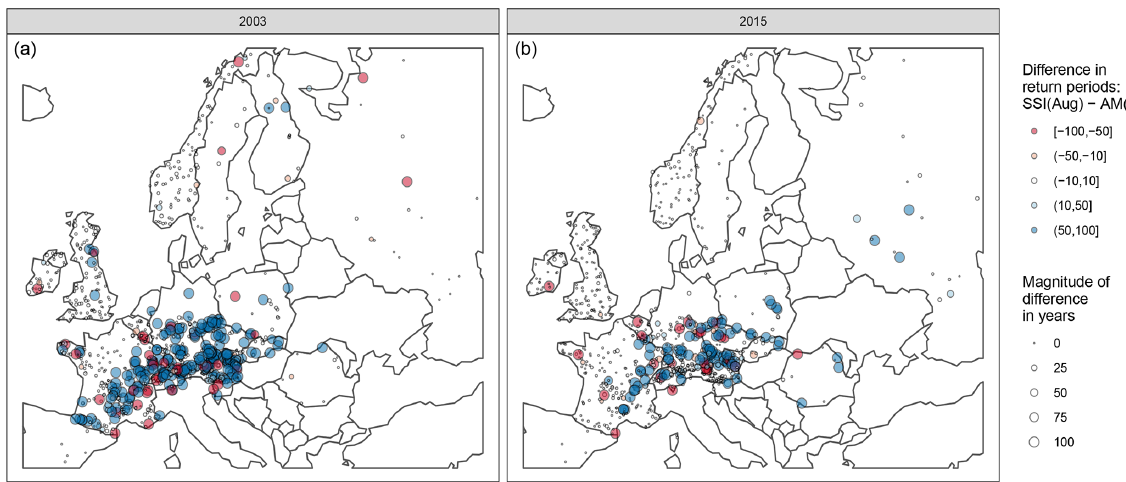
Figure 2. Difference in the return periods T of the droughts in 2003 (a) and 2015 (b) estimated by SSI(August) and AM(7) with differences given in Years as: T SSI(August) – T AM(7) , resulting in positive differences (blue colors), where T SSI estimates a higher T (more severe event) and negative differences (red colors), where T AM(7) estimates a more severe event. Methods and data are based or an extension of the streamflow drought dataset from Laaha et al.